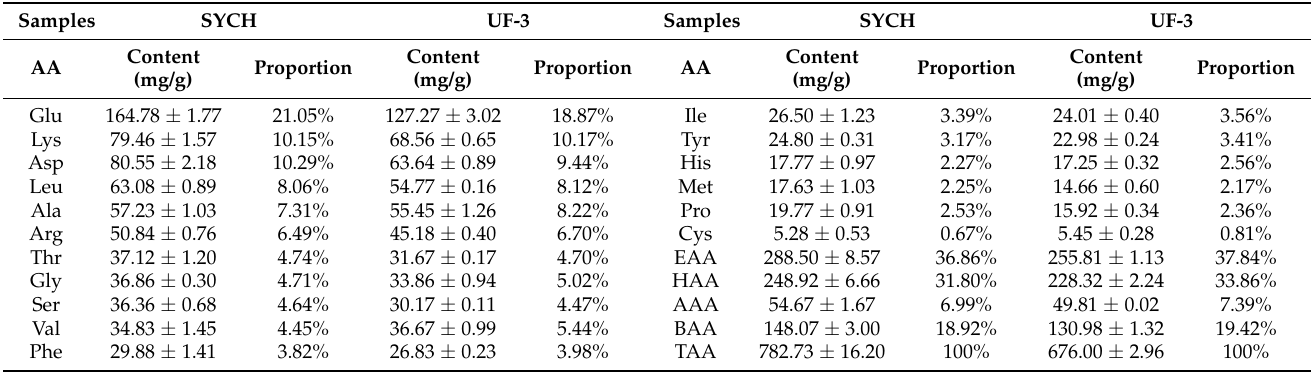
Table 2. Amino acid composition of small yellow croaker hydrolysates and